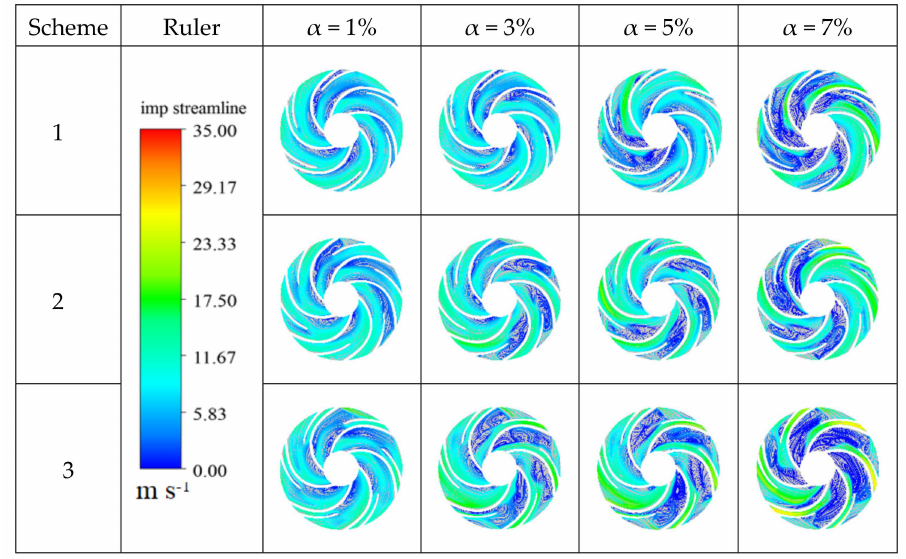
Figure 10. Liquid phase velocity streamline diagram of the impeller flow field cross-section for each inflow gas volume fraction of each scheme under the design